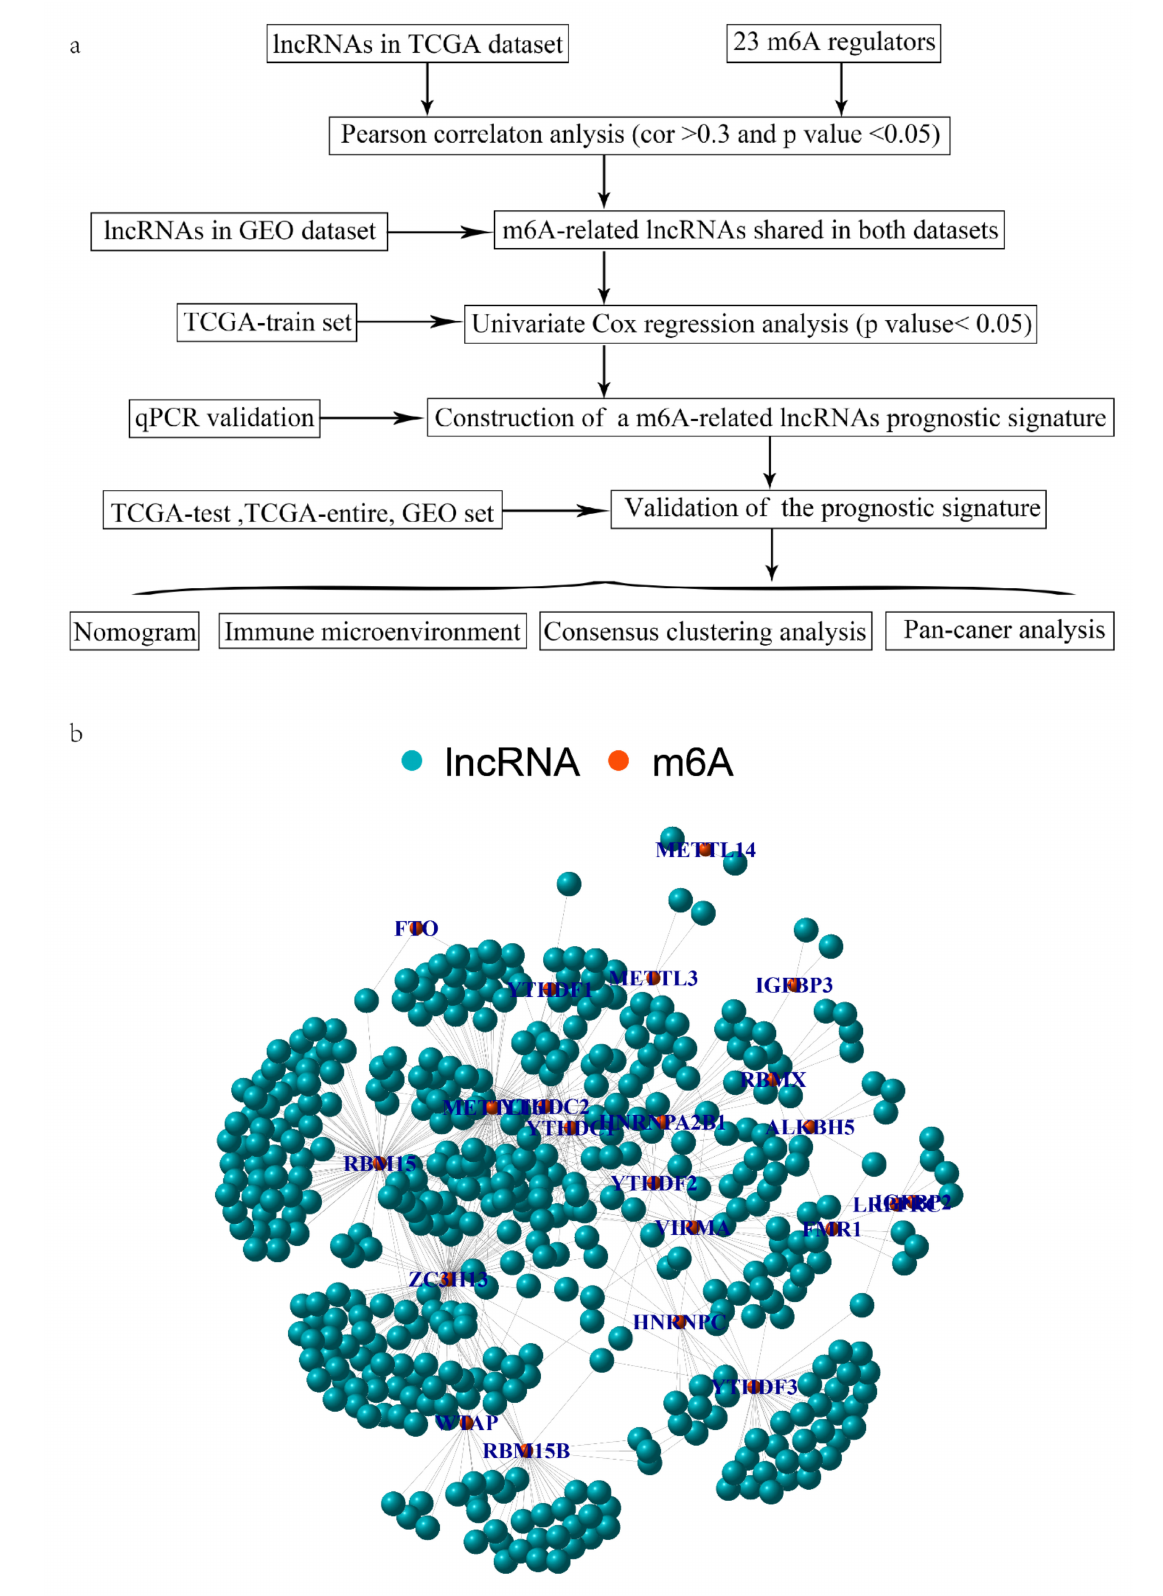
Figure 1. ( a ) Flow chart of the study and ( b ) co-expression network diagram of m6A regulators and lncRNAs in the TCGA